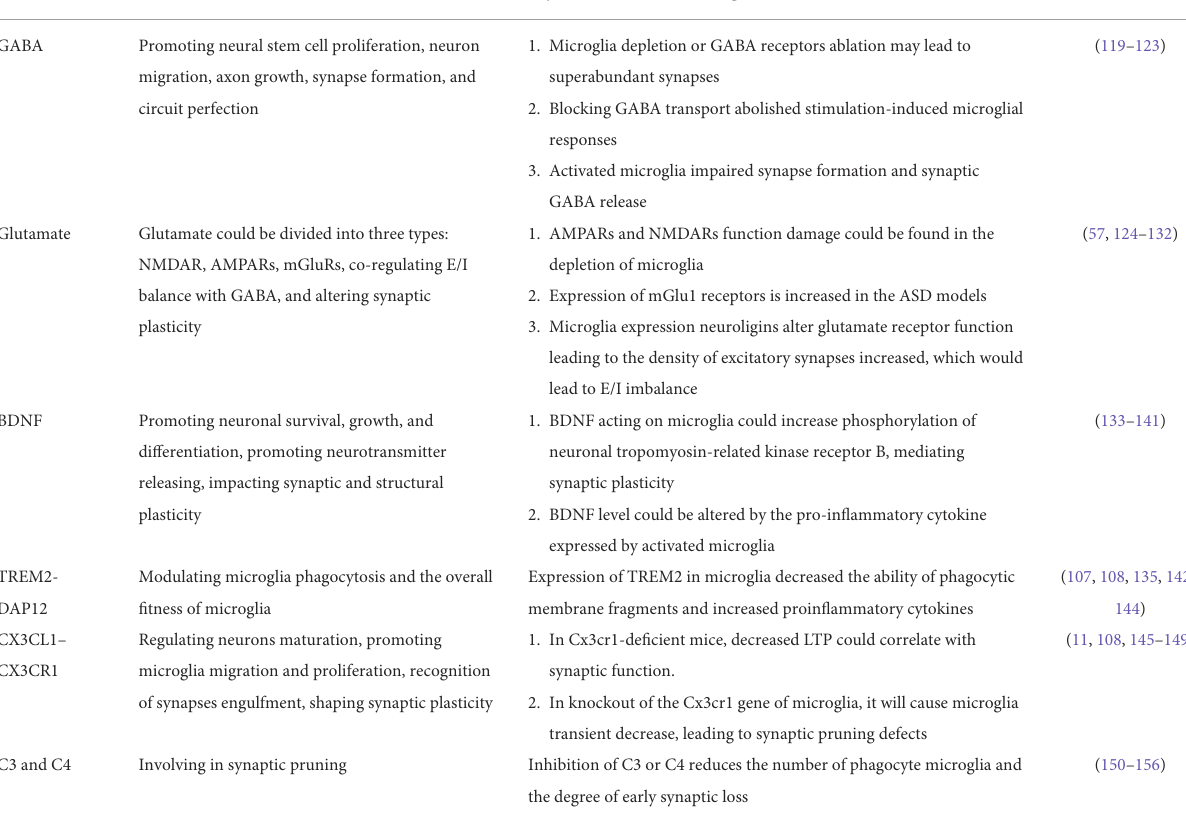
TABLE 1 Related mechanisms in microglia acting on